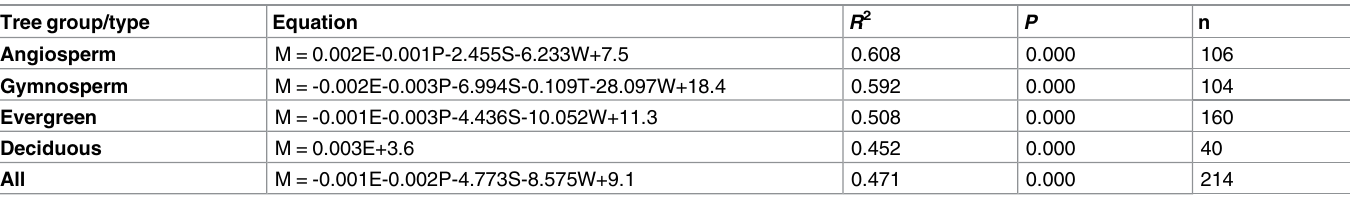
Table 3. Stepwise regression to identify factors (elevation, mean annual precipitation, mean annual temperature, standardized precipitation- evapotranspiration index, and wood density) determining the annual mortality rate during droughts. M, annualmortality rate duringdroughts; E, ele- vation; P, mean annualprecipitation; T, mean annualtemperature; S, standardized precipitation-evapotranspirationindex; W, wood